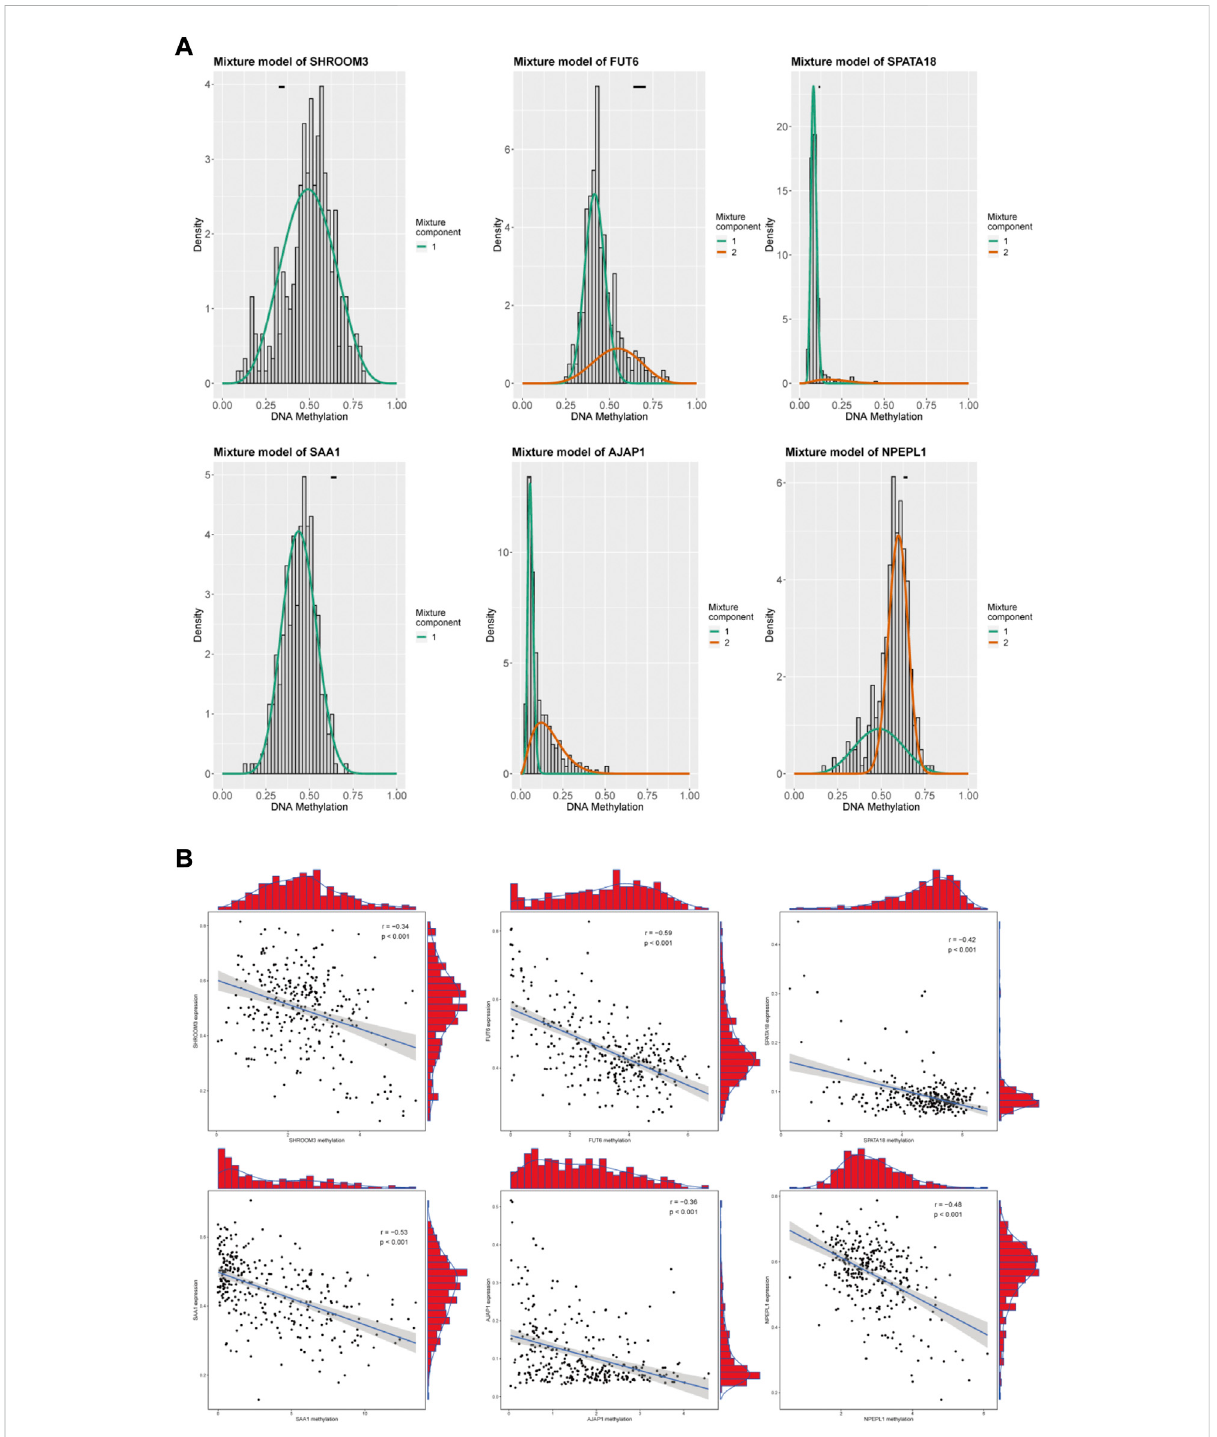
FIGURE 3 SummaryoftheSixmethylation-drivengenes. (A) Thedistributionmapshowingthemethylationdegreeofmethylation-drivengenesinccRCC. (B) Regression analysis between gene expression and DNA